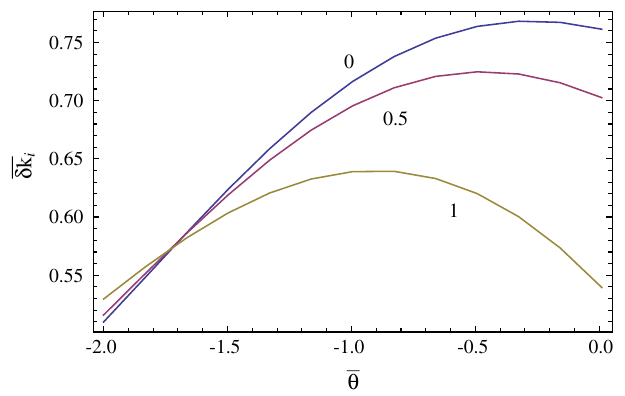
(cid:1) ¼ 0 , (cid:2) p